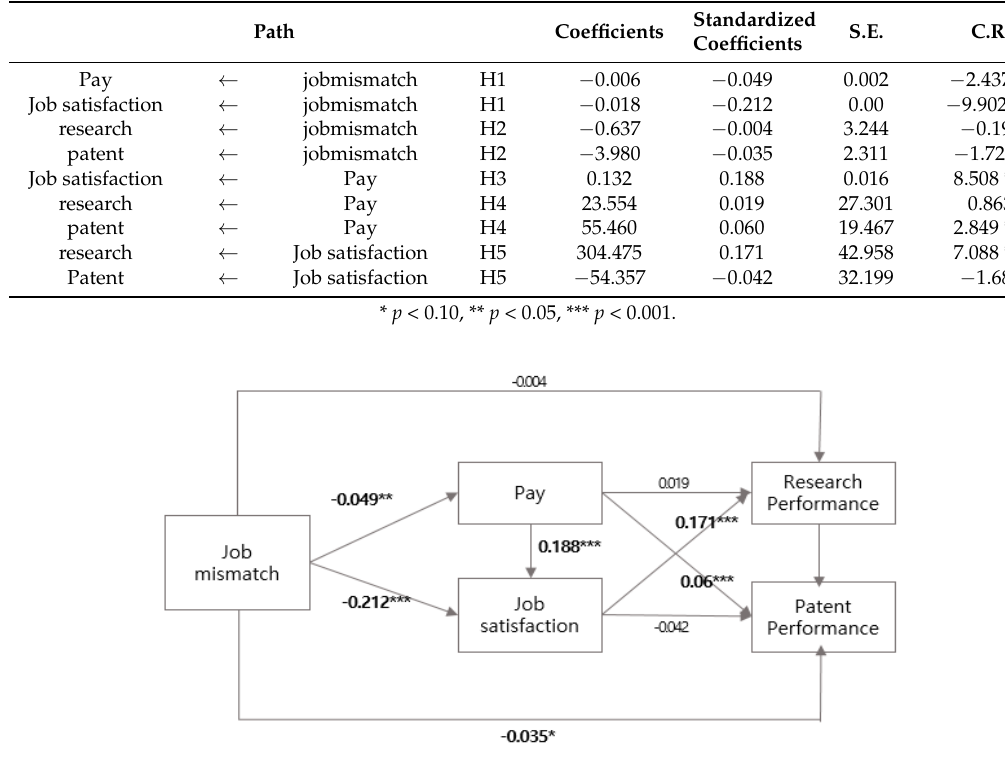
Figure 1. The SEM analysis. Note: * p < 0.10, ** p < 0.05, *** p < 0.001.